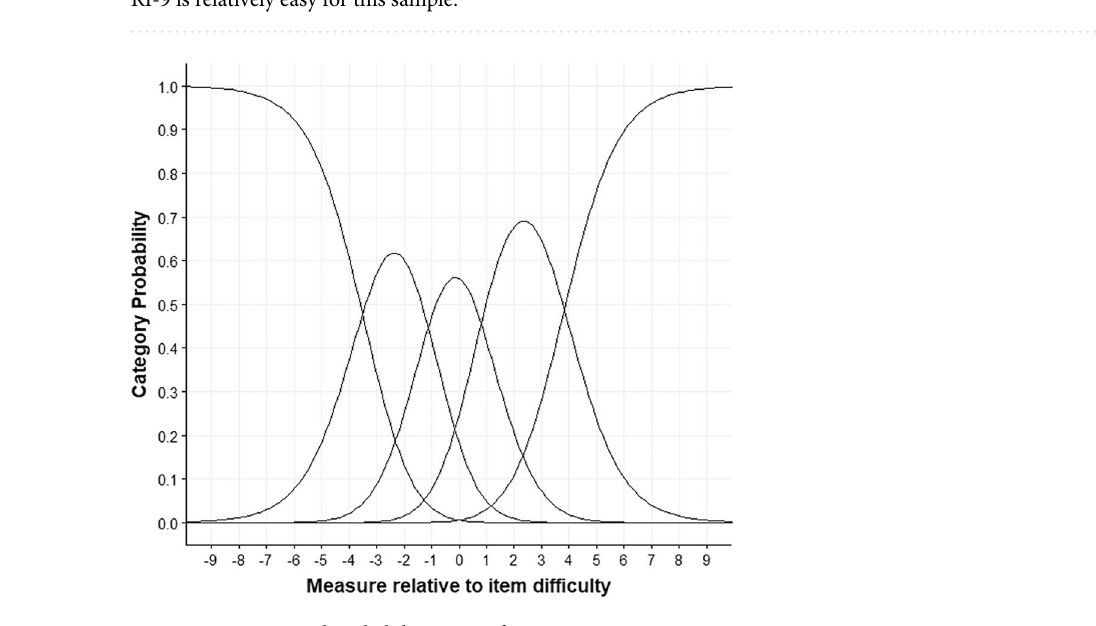
Figure 2. Categorical probability curves for